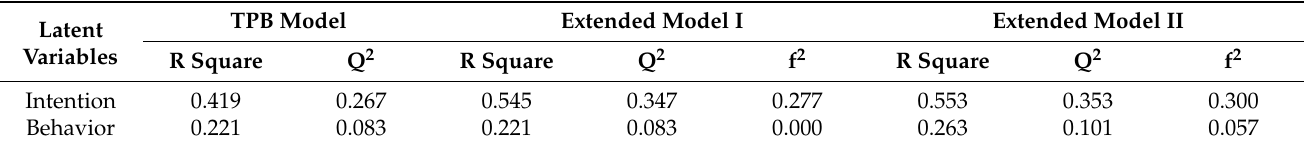
Table 5. The results of the coefficient of determination (R 2 ), predictive relevance (Q 2 ), and effect value (f 2 ).